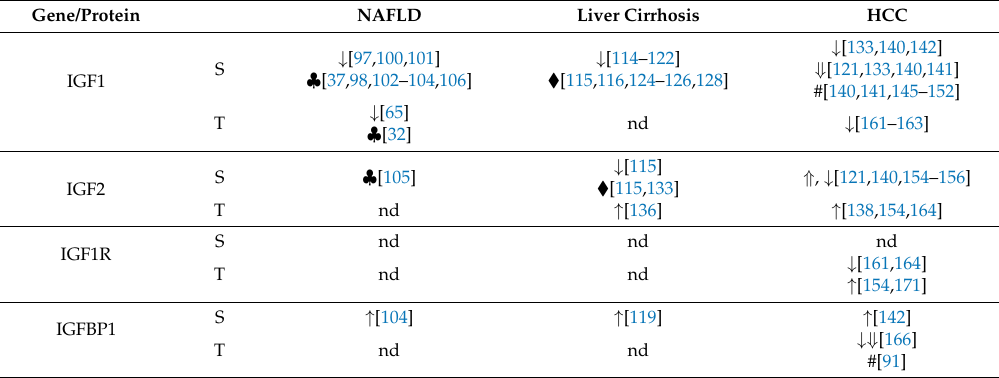
Table 1. Serum levels and tissue expression changes in the IGF/IGFR pathway in chronic liver diseases.